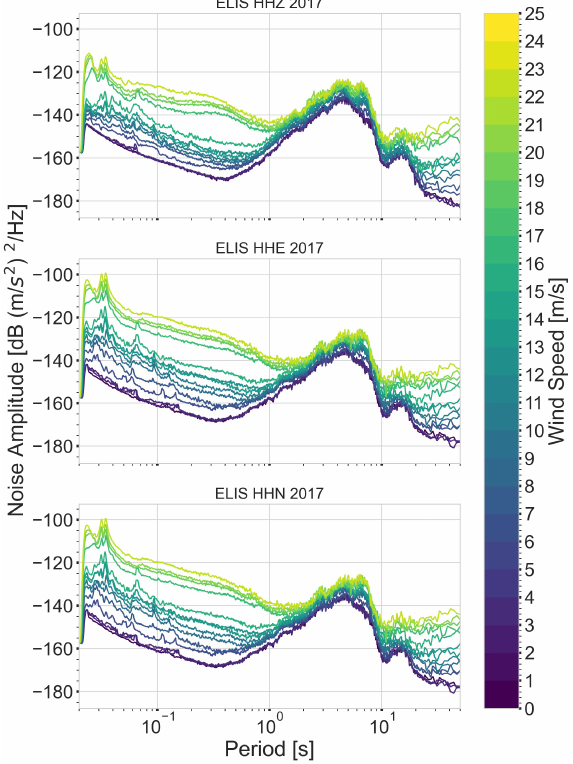
Figure 2. The 2017 ELIS PSDs computed for 0–25ms − 1 wind speed. HHZ, HHE, and HHN are the vertical, east–west, and north– south channels, respectively.